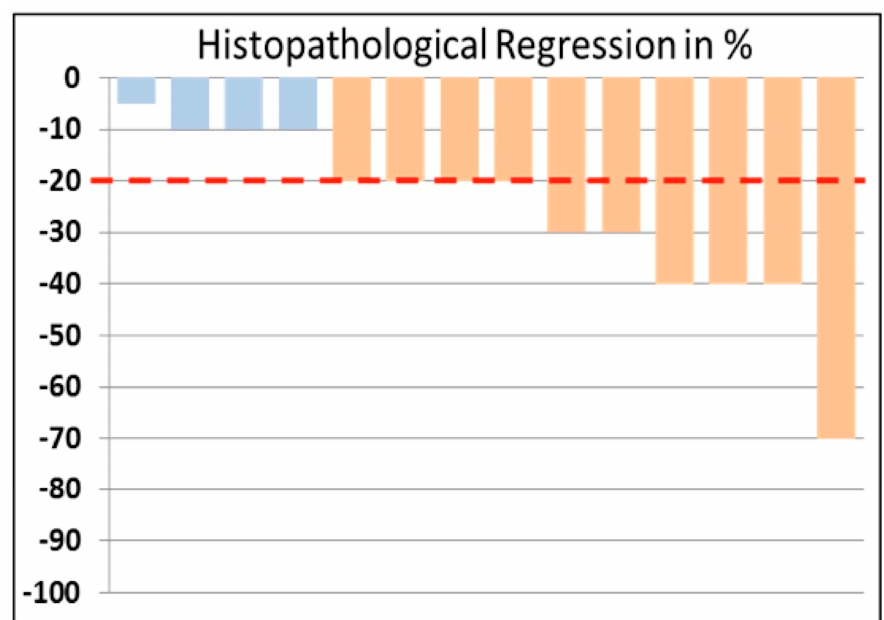
Figure1. Waterfallplotofthegradeofhistopathologicalregression, availablefor14patients. Tenpatients Figure 1. Waterfall plot of the grade of histopathological regression, available for 14 patients. Ten had a reduction in vital tumor tissue of > 20%, while four patients demonstrated a reduction of less patients had a reduction in vital tumor tissue of >20%, while four patients demonstrated a reduction than 20%. of less than 20%.